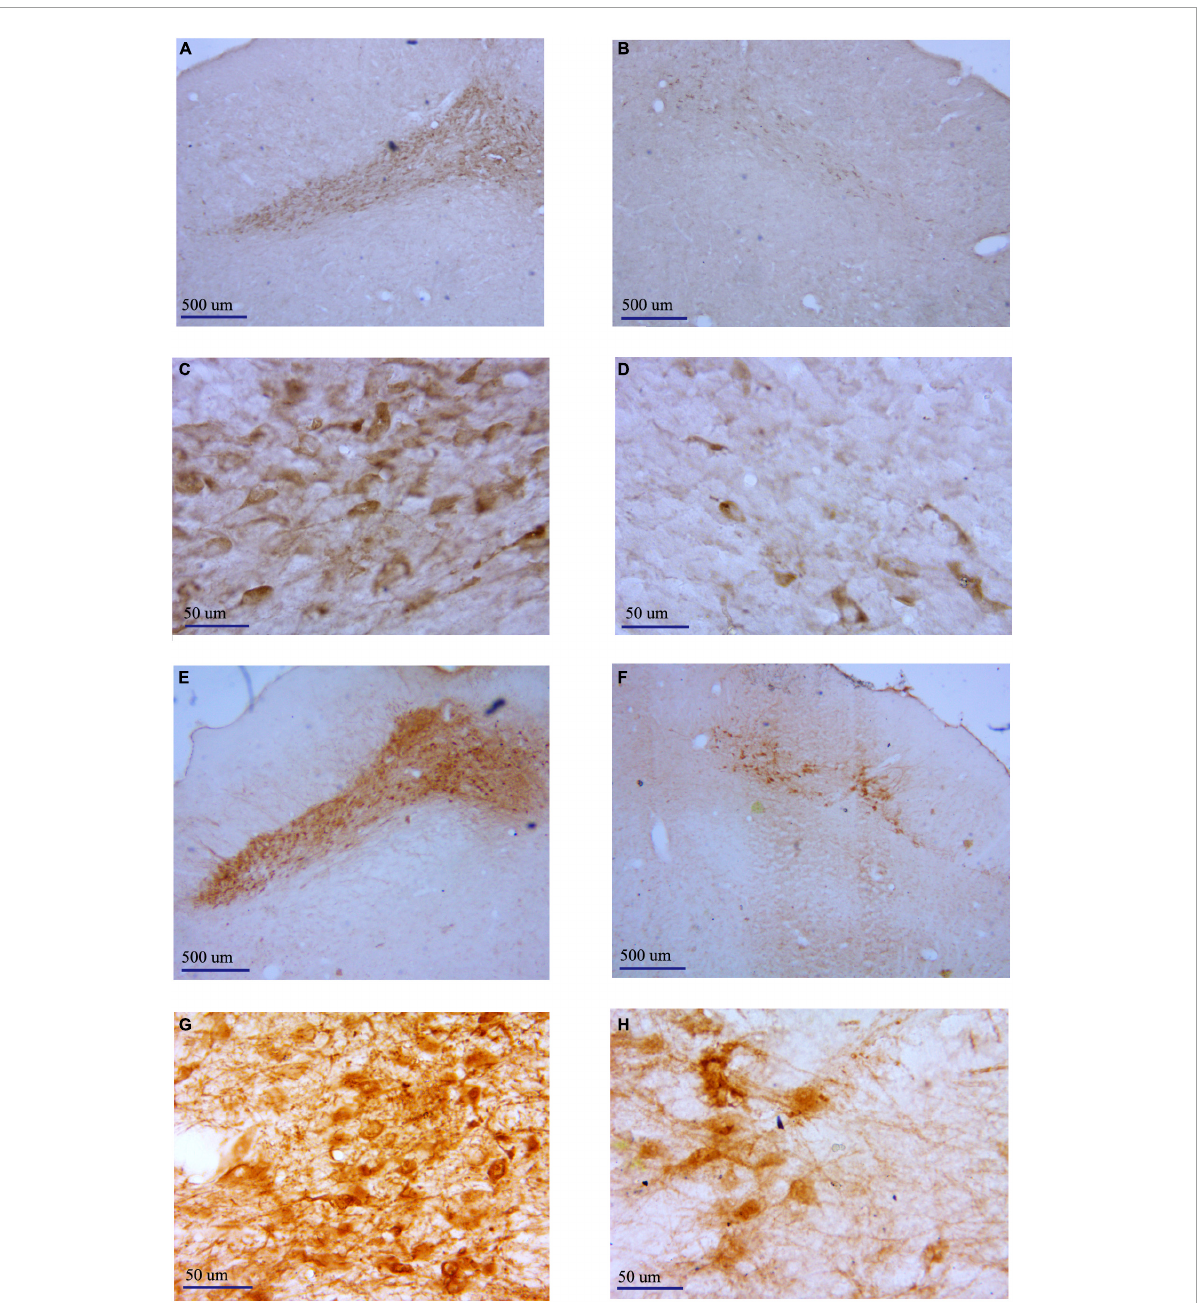
FIGURE5 Representative pictures showing TH + neurons in the SNc of different groups determined by immunostaining. (A) Non-lesioned side SNc of rats in the 6-OHDA-lesioned group (40 × ). (B) Lesioned side SNc of rats in the 6-OHDA-lesioned group (40 × ). (C) Non-lesioned side SNc of rats in the 6-OHDA-lesioned group (400 × ). (D) Lesioned side SNc of rats in the 6-OHDA-lesioned group (400 × ). (E) Non-lesioned side SNc of rats in the DBS group (40 × ). (F) Lesioned side SNc of rats in the DBS group (40 × ). (G) Non-lesioned side SNc of rats in the DBS group (400 × ). (H) Lesioned side SNc of rats in the DBS group (400 × ).